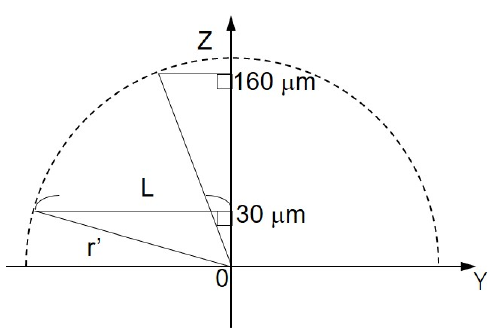
Figure 6. ( A ) XY ‐ scan images showing the oxygen concentration distribution with the distance be ‐ tween Pt microelectrode and the cell chip of 30  m ( a ) and 160  m ( b ). Line (L 1 ) and (L 2 ) are on the same X coordinate. Graph ( B ) shows the oxygen reduction current values of line (L 1 ) and line (L 2 ).